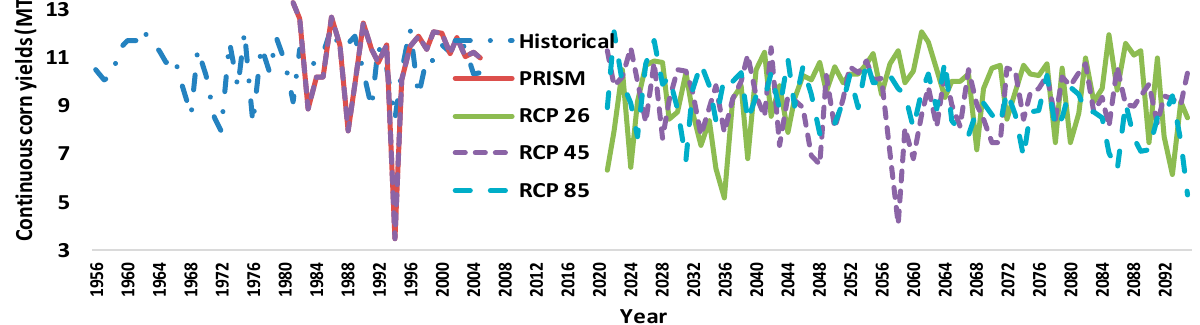
Figure 4. Graph of annual simulated continuous corn yields by climate scenario.